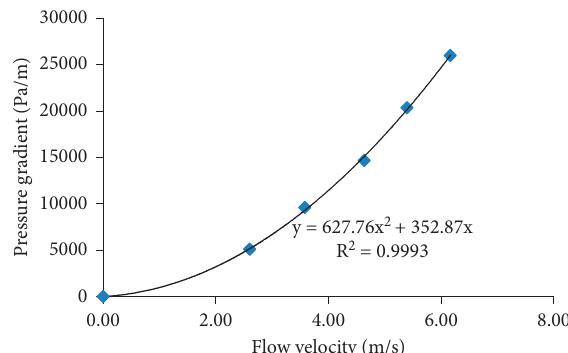
Figure 7: Flow velocity vs. water head gradient.